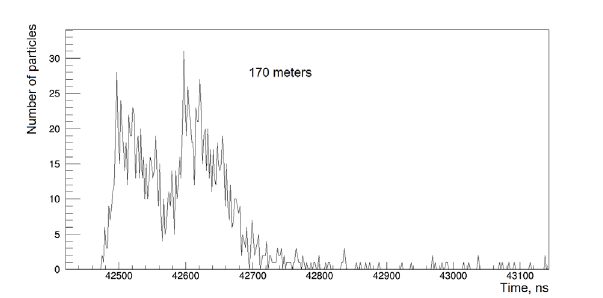
Figure 11. Two EAS disks with 100ns delay, detector is 170 m from